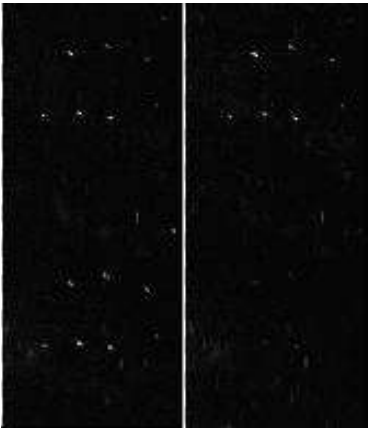
Figure 7. Enlargements of the selected areas in Figure 5: (a) corresponding to Figure 5a, and (b) corresponding to Figure